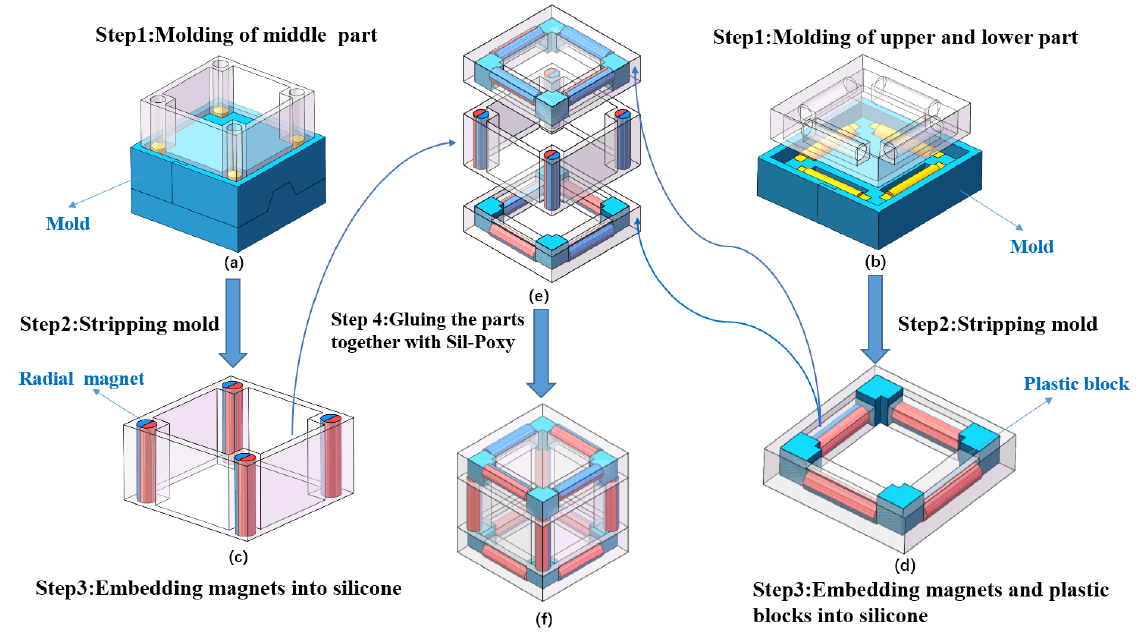
Figure 3. The fabrication process of soft cubes.